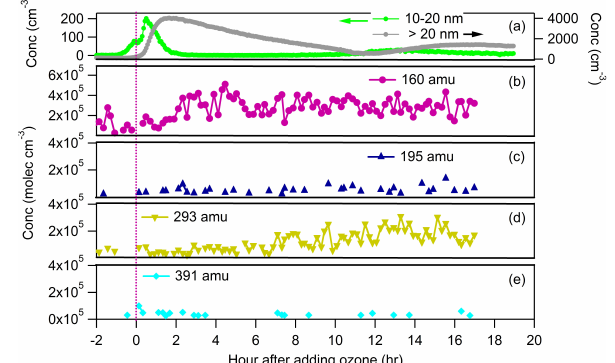
Fig. 5. (a) Time-dependent concentrations of ions corresponding to sulfuric acid and its clusters containing up to 4 H 2 SO 4 , along with the concentrations of 10–20nm particles and > 20nm particles for E1 ( b 160amu, monomer; c 195amu, dimer; d 293amu, likely organic species other than trimer; e 391amu,